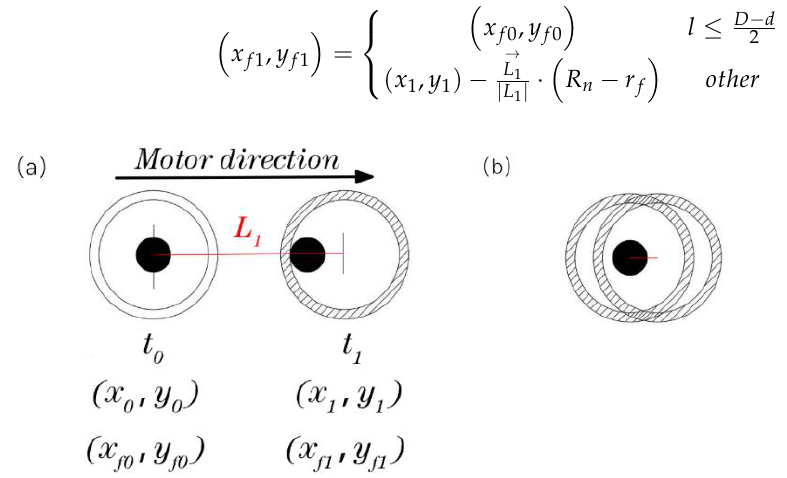
Figure 11. Line-following model, ( a ) line-following, ( b ) special cases. When the fiber-reinforced composite filament moves from a straight line into a turn, the position of the fiber filament relative to the nozzle center will change until the turning is completed, and the fiber is finally in the opposite direction of the linear motion of the nozzle after the turn. Figure 12a–d, respectively, indicates that the fiber-reinforced composite filament moves in a straight line from the initial state of t 0 to time t 1 , turns from time t 1 to time t 2 , and enters the turning state to the end of turn t 3 , and also shows the positions of the fiber filament in the nozzle changes. Figure 13 shows the change of the position of the filament at different times in the nozzle at different turning angles. Turning track 1 represents an obtuse-angle turn, turning track 2 represents a right-angle turn, and turning track 2 represents an acute-angle turn.